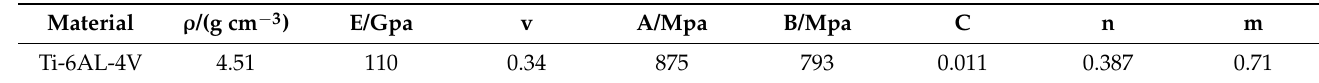
Table 2. Johnson-Cook parameters of Ti-6AL-4V.